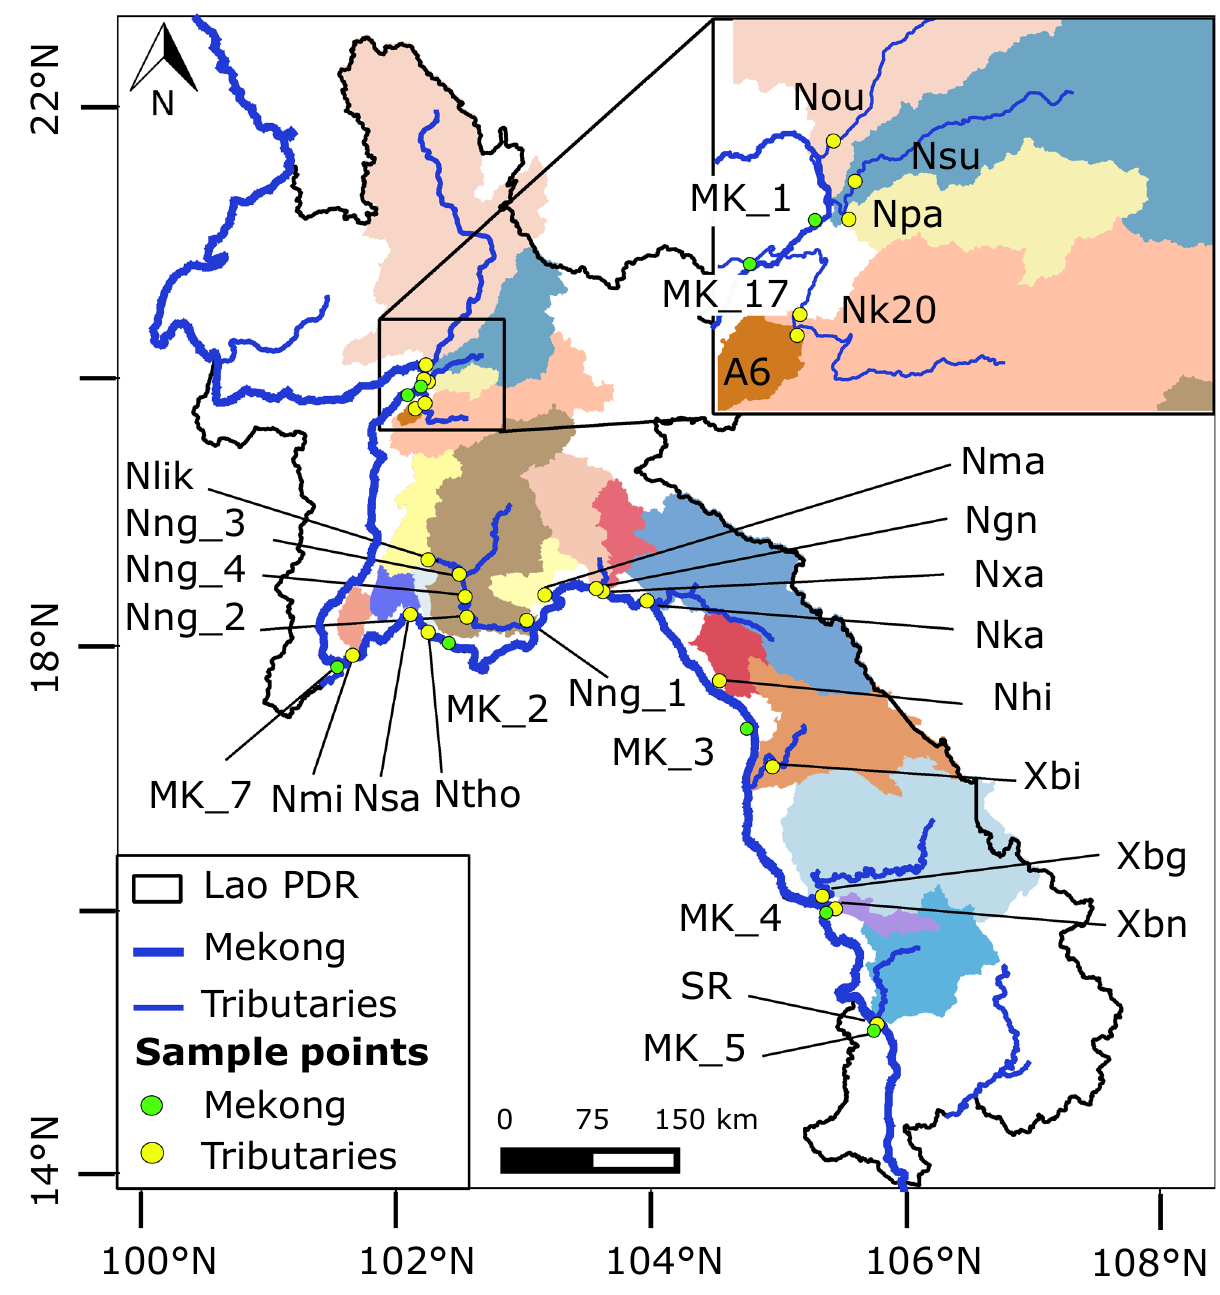
Figure 1. Mekong river and watersheds of Mekong tributaries (colored areas) sampled in March and July 2016 in Lao PDR. Geographic coordinate system: WGS 1984, latitude and longitude in degrees. Map generated